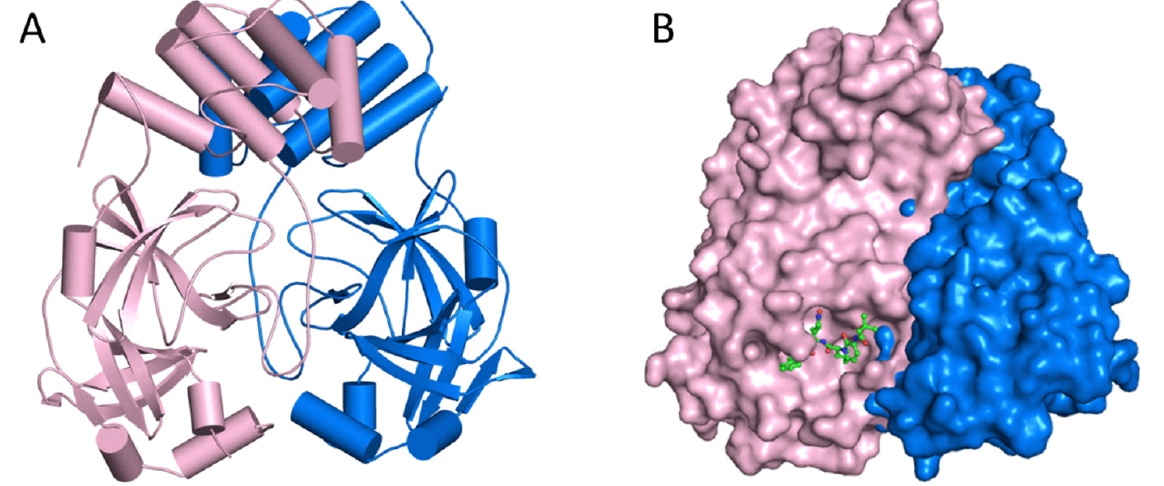
Figure 4. ( A ) The major protease of the SARS-CoV-2 dimer’s structural characteristics. The primary protease of the SARS-CoV-2 virus. ( B ) In the active site groove, a sphere represents the primary protease monomer.